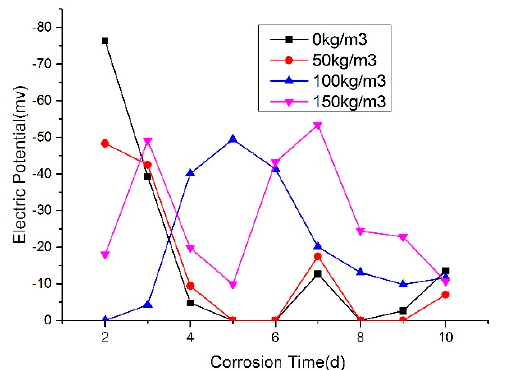
Figure 10. Potential value of W/C = 0.45.